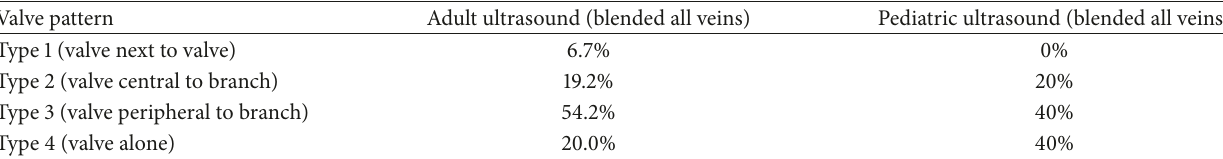
Table 3: Comparison of valve patterns across studied